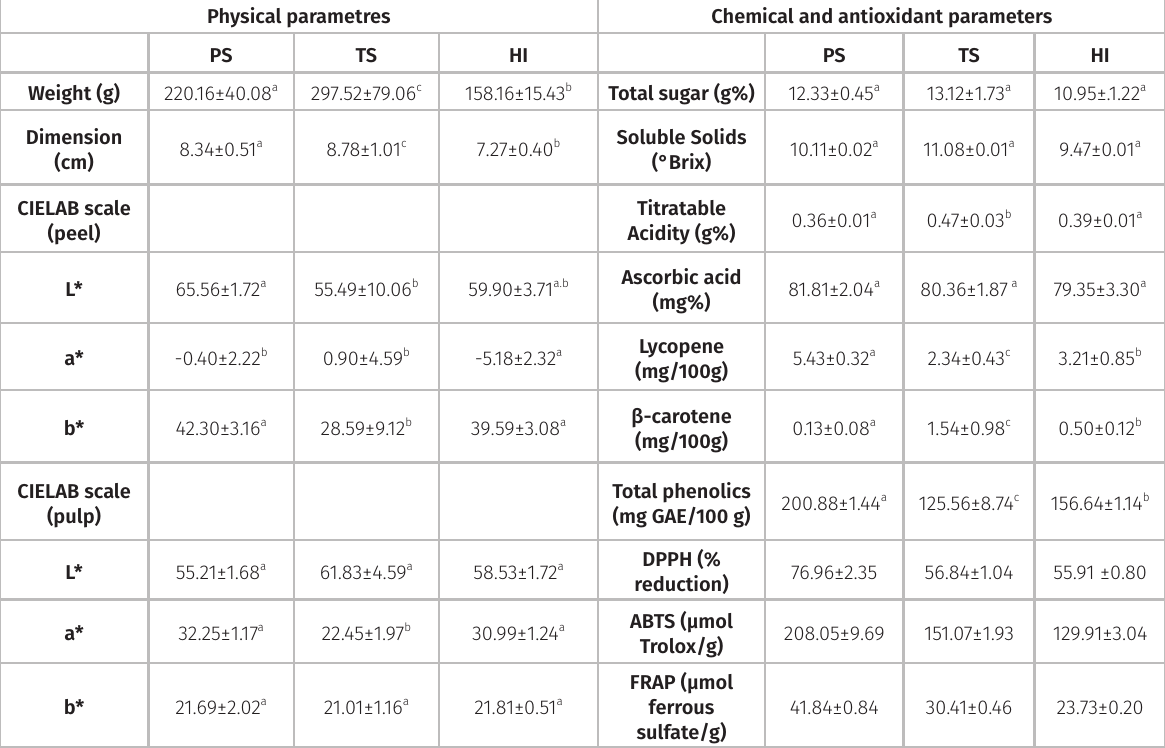
Table I. Physical and chemical characterization of guava cultivar extracts. Significant differences are indicated as a, b and